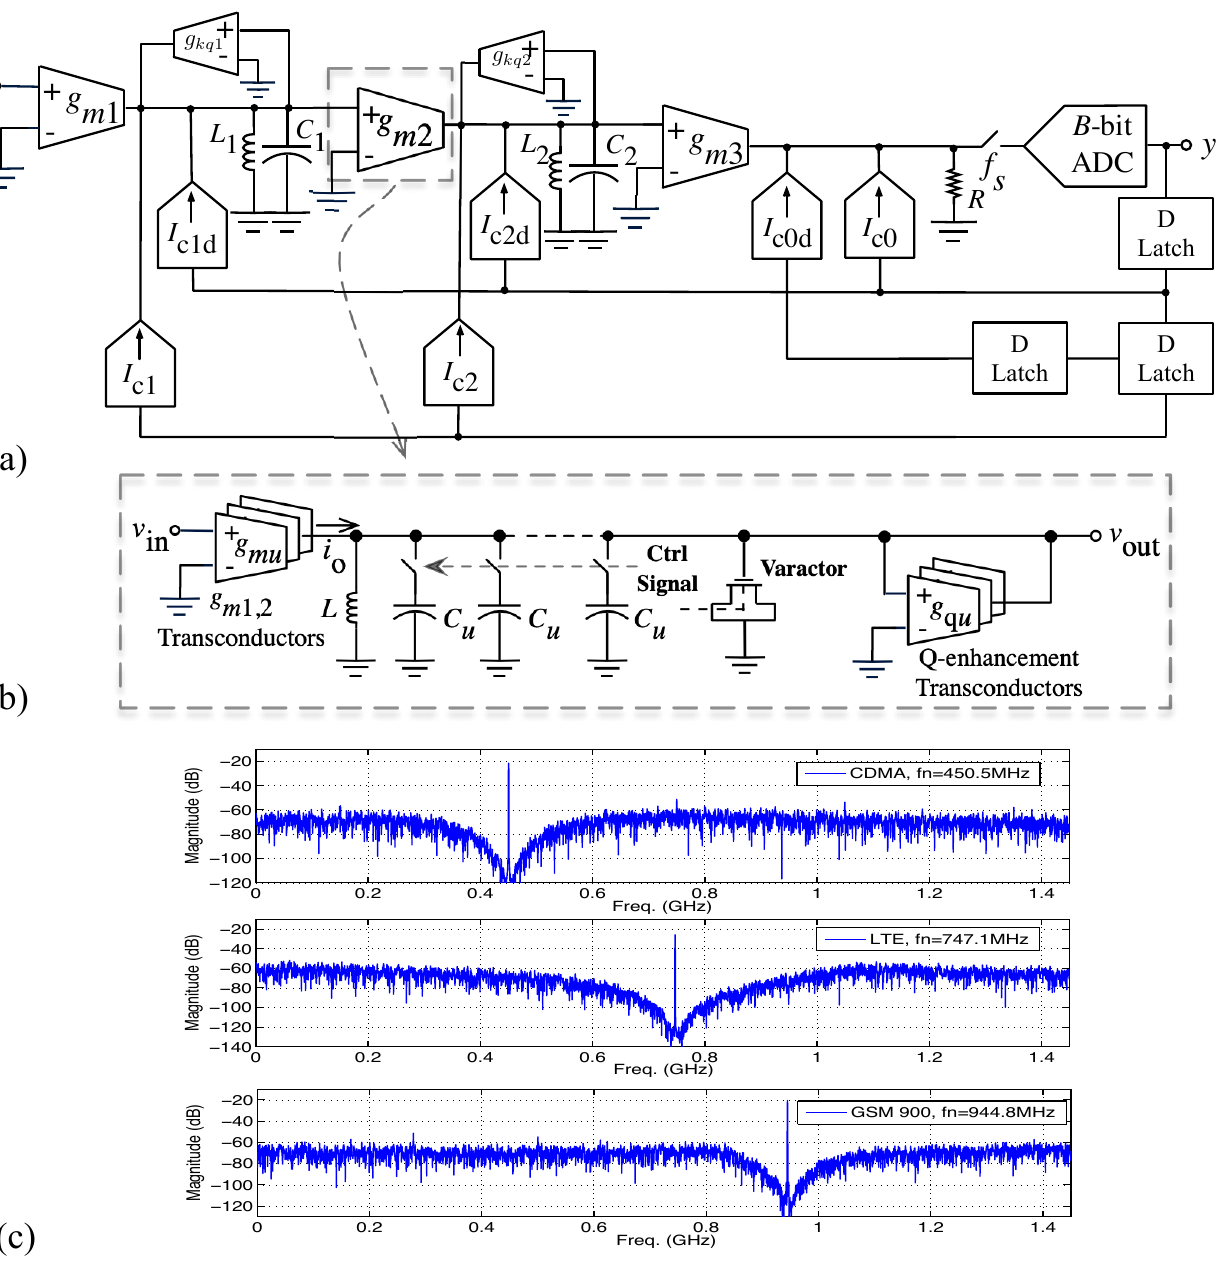
Figure 11. Tunable CT BP- Σ∆ Ms. ( a ) Block diagram, ( b ) Gm-LC resonator. ( c ) Output spectra